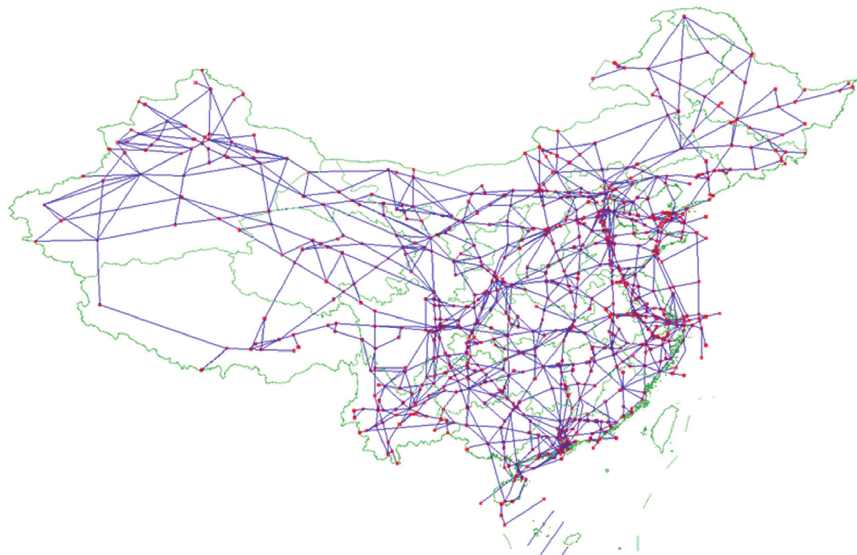
Figure 3: The distribution of Chinese air route